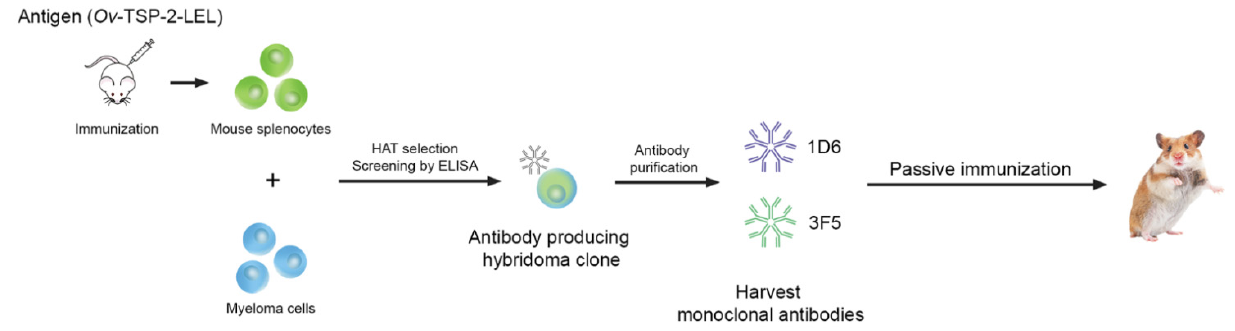
Figure 1. Hybridoma generation was performed by immunization of mice with adjuvanted Ov -TSP-2-LEL and fusion of splenocytes with SP2/0 myeloma cells. After isolation of hybridomas by HAT selection, the supernatants that contained mAbs from each clone were screened by ELISA to select antibody producing clones. After several rounds of screening, two IgM antibody producing clones, 1D6 and 3F5, were selected and purified for passive immunization of hamsters.